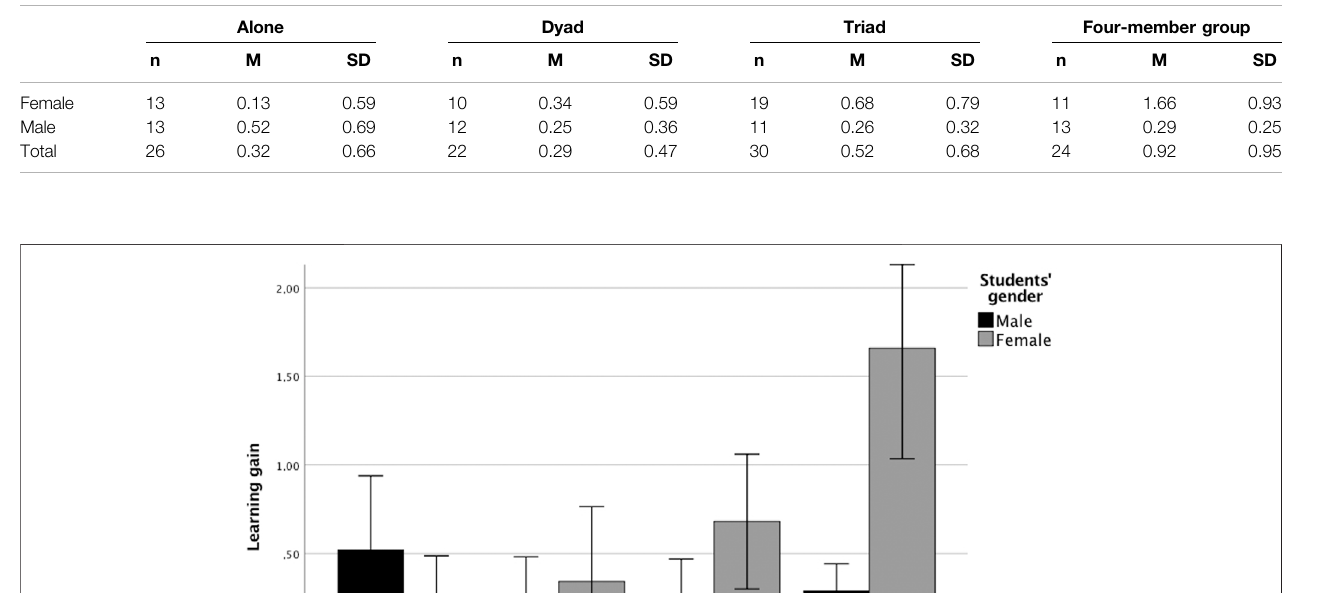
TABLE 2 | Means (M) and Standard Deviation (SD) of learning gain for each experimental condition according to students ’ gender.